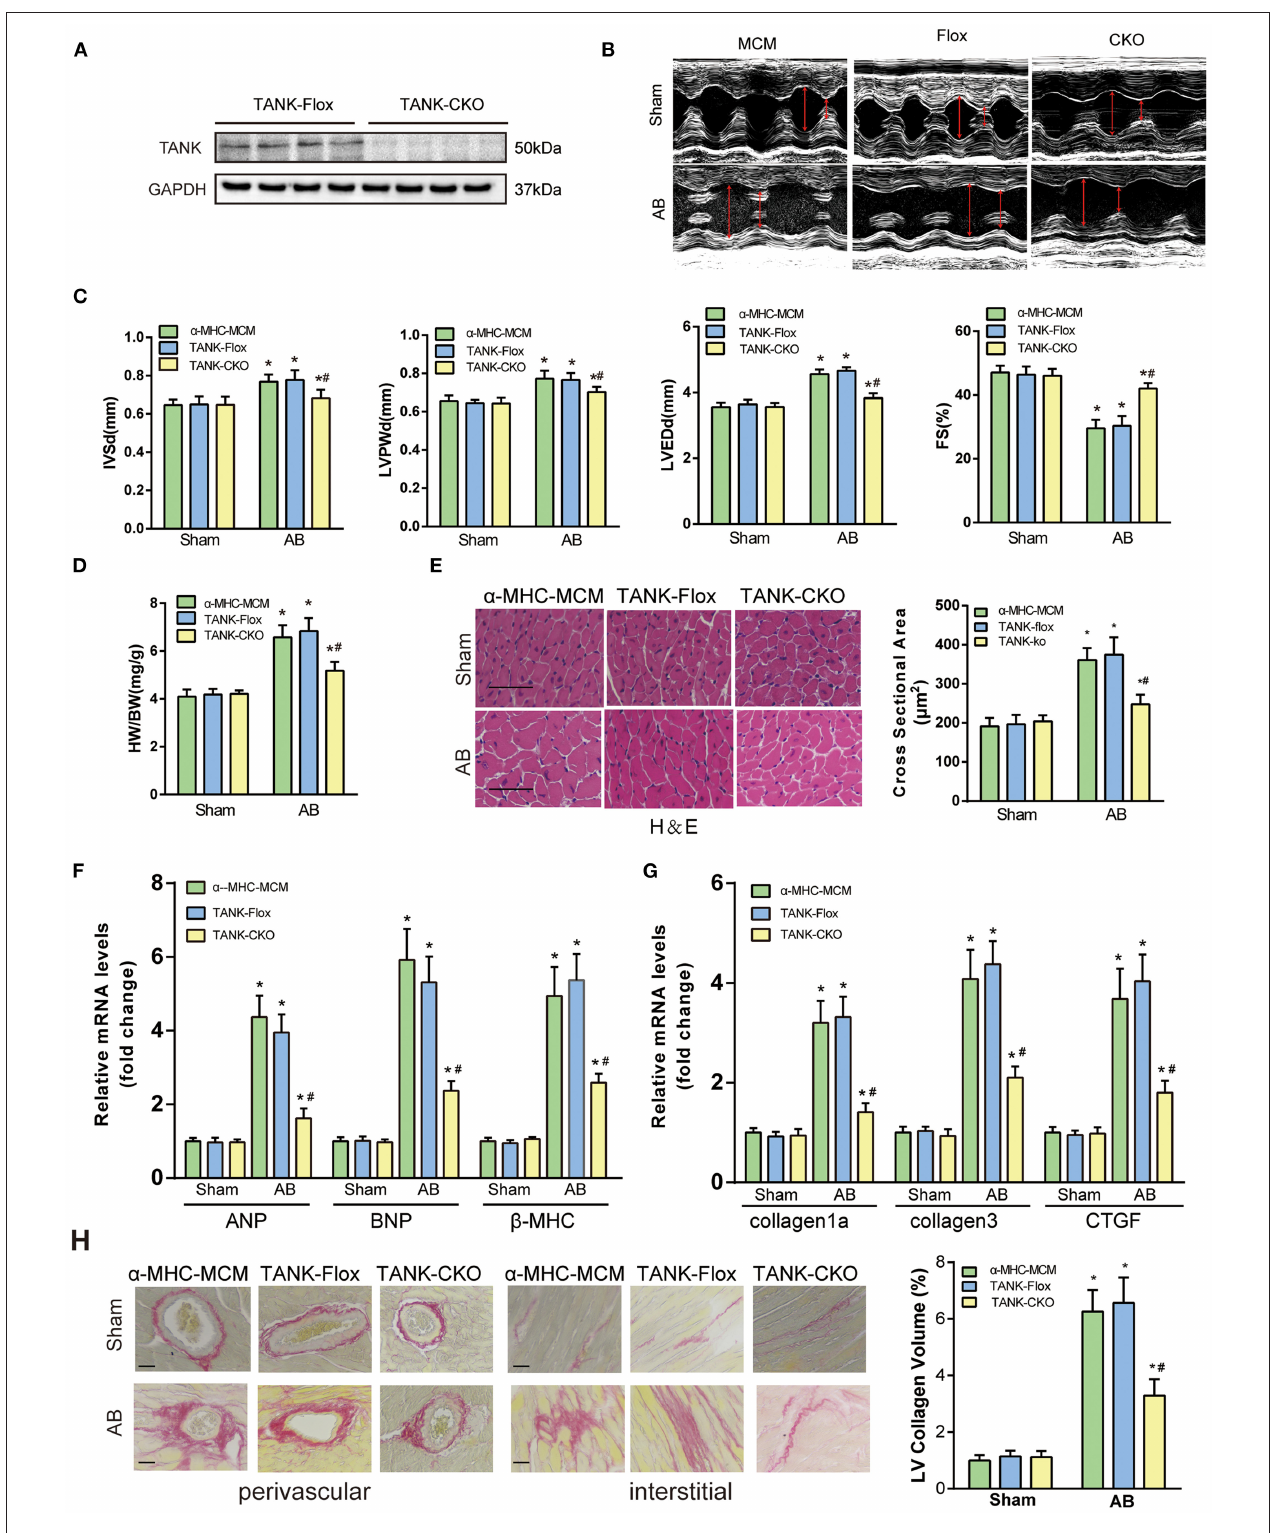
FIGURE 4 | TANK cardiac-specific deficiency ameliorates pressure overload-induced cardiac hypertrophy. (A) Representative western blot showing TANK expression in the TANK-Flox and TANK conditional knockout (TANK-CKO) groups ( n = 4 mice per group). (B) M-mode echocardiograms from control groups and